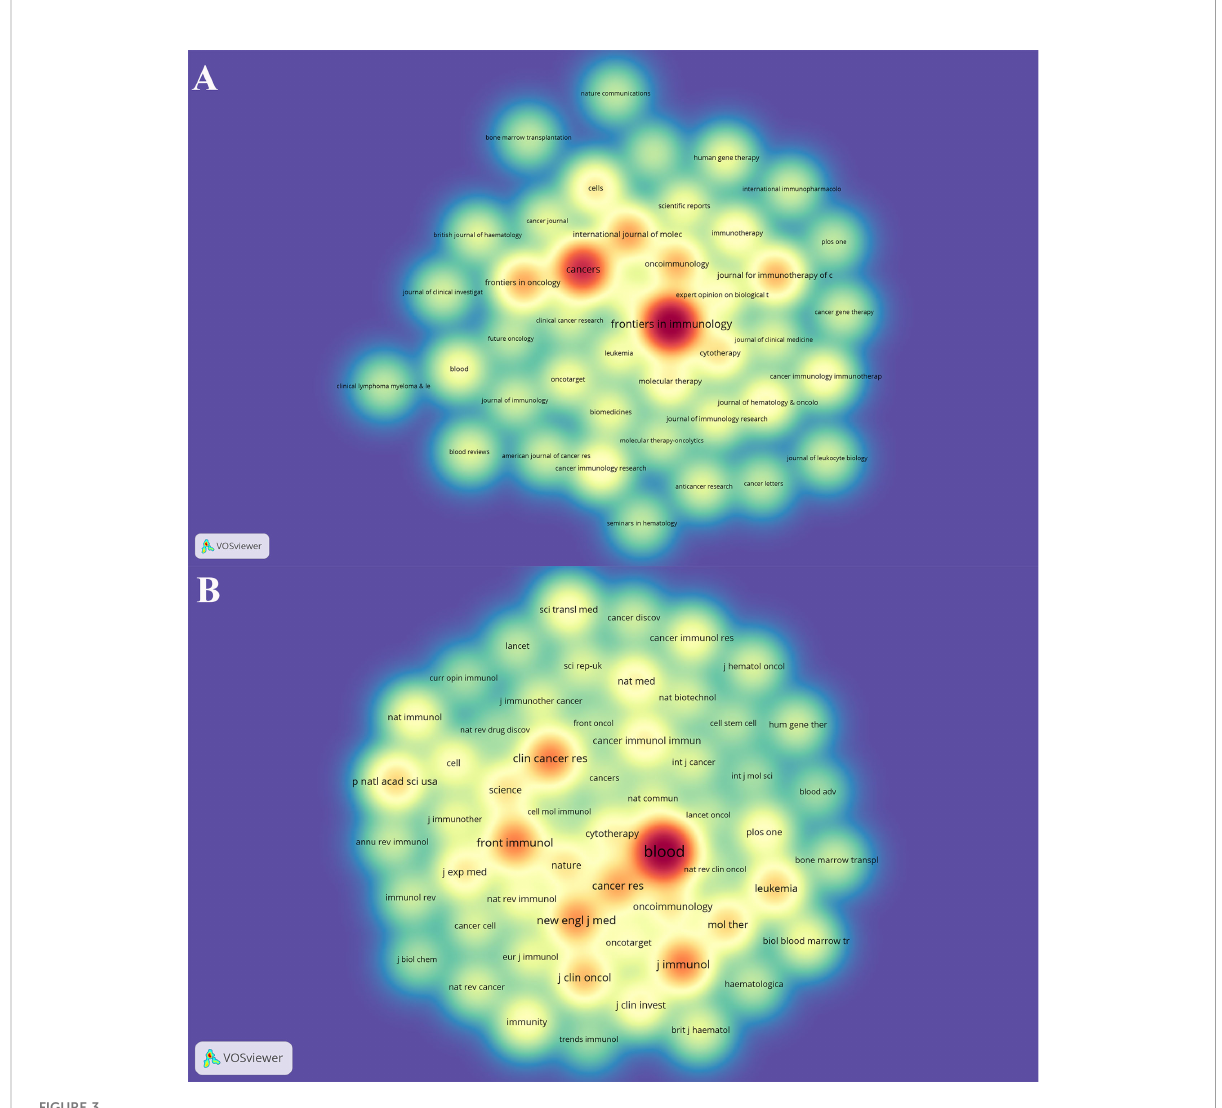
FIGURE 3 The density map of journals (A) and co-cited journals (B) in the CAR-NK cell fi eld. Figure A shows journals with a number of publications ≥ 5; Figure B shows the journals with citations ≥